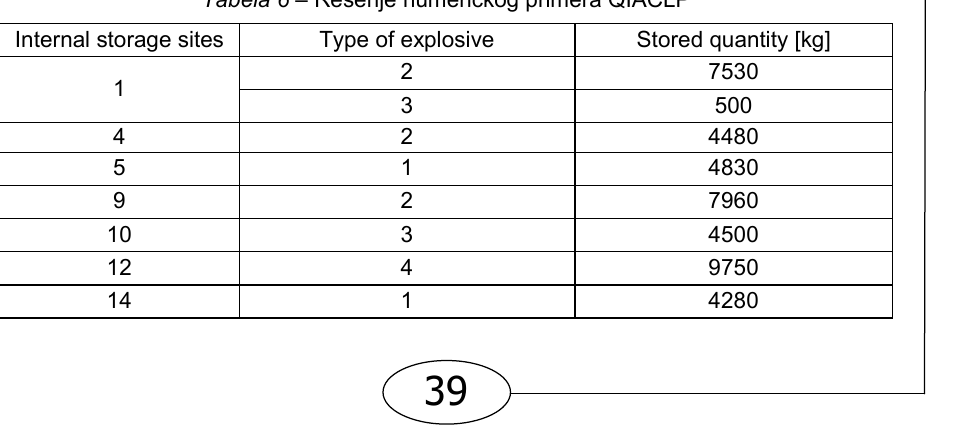
Table 6 – Solution of the QIACLP numerical